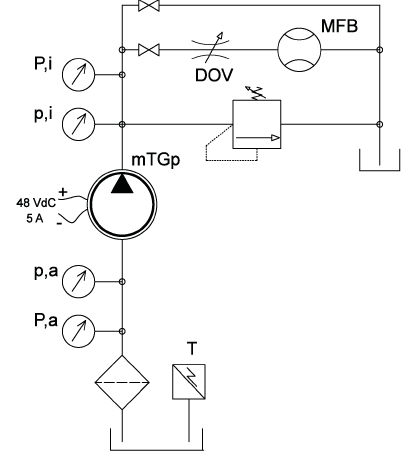
Figure 11. In-house mini test bench structure.